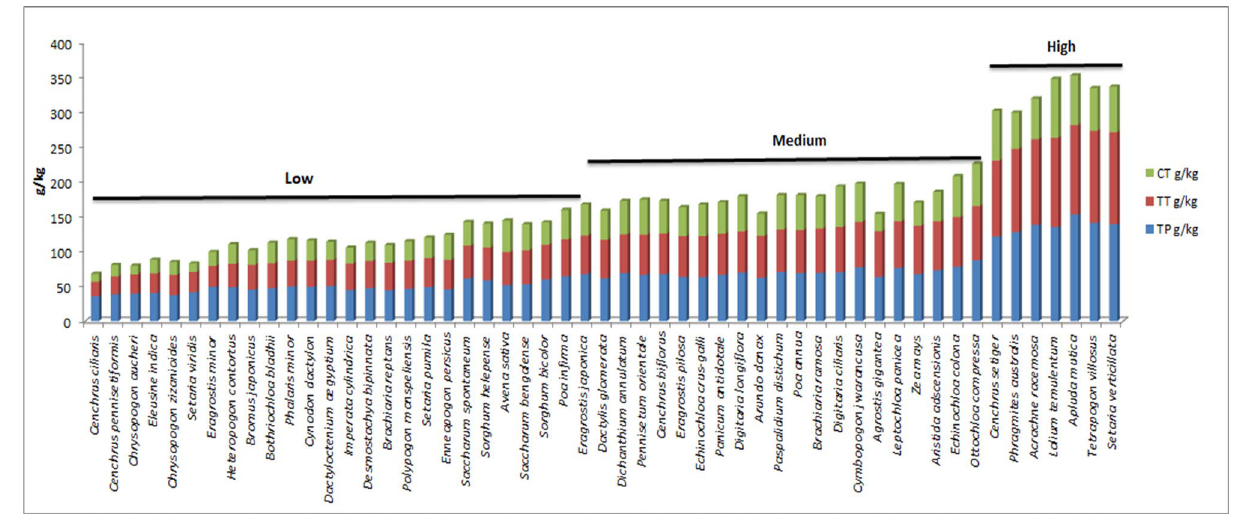
Figure 2. Clustering of ethnobotanical fodder grasses based on their secondary metabolite contents i.e. high (> 100 g/kg), moderate (50–100 g/kg) and low (< 50 g/kg). Here, greater number of species were in low (24) followed by moderate (22) and high (7) grass